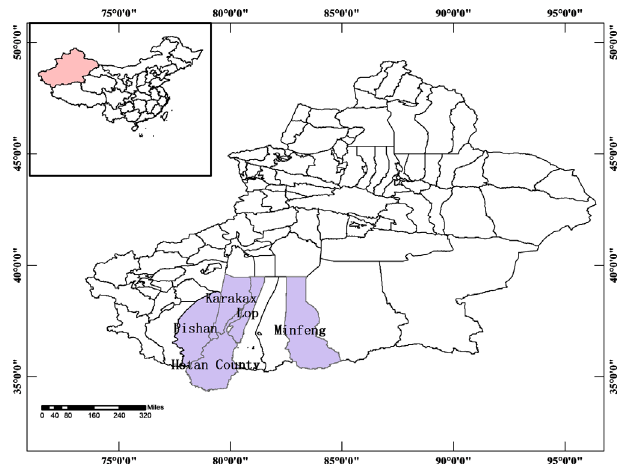
Figure 1. Speci fi c locations where specimens were collected in this